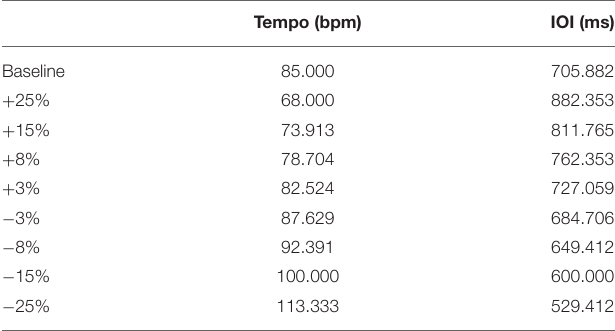
TABLE 1 | Tempo and inter-onset interval perturbation values referenced to the baseline (no perturbation)